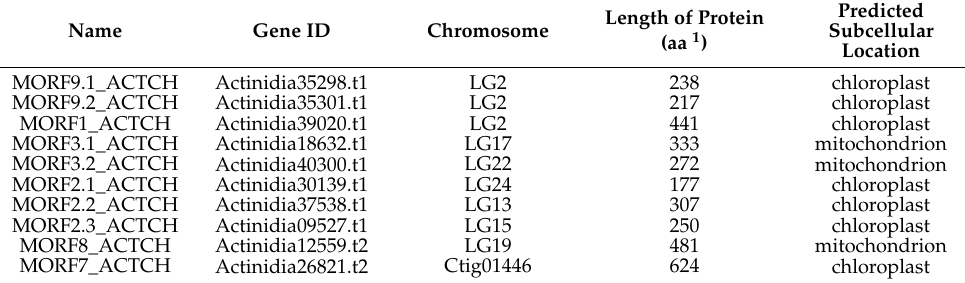
Figure 2. Classification, motif annotation, and genomic structures of MORF genes in kiwifruit. The phylogenetic tree is shown in the left panel, whereas conserved motifs and genomic structures are shown in the right two panels. The phylogenetic tree from full-length amino acid sequences was constructed using the MEGA with maximum likelihood (ML) method. Three conserved motifs are indicated by different colored boxes. CDSs and UTRs are indicated by yellow and green boxes, respectively. Their sizes are estimated using the length scale at the bottom. Table 1. The characteristics of putative MORF genes in kiwifruit.